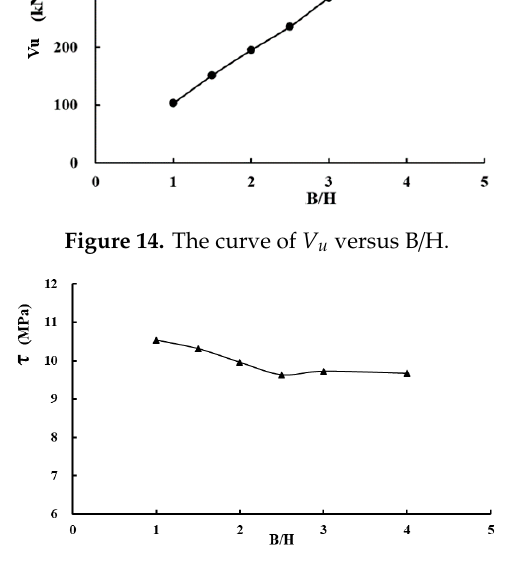
τ versus B / Figure 15. The curve of τ versus B/H. Figure 15. The curve of Figure 15. The curve of τ versus B/H.